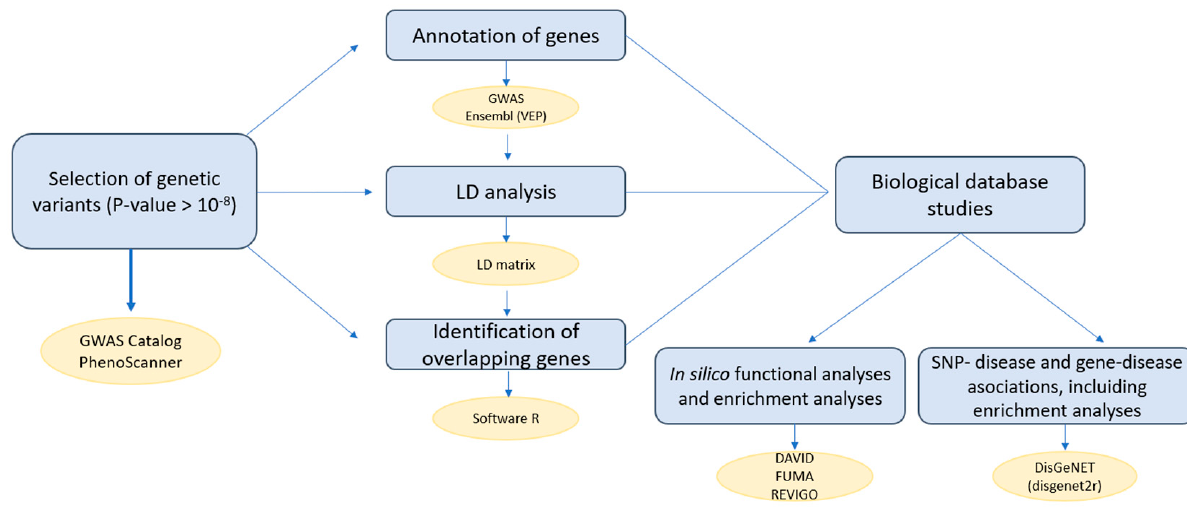
Figure 6. Workflow of the data analysis.